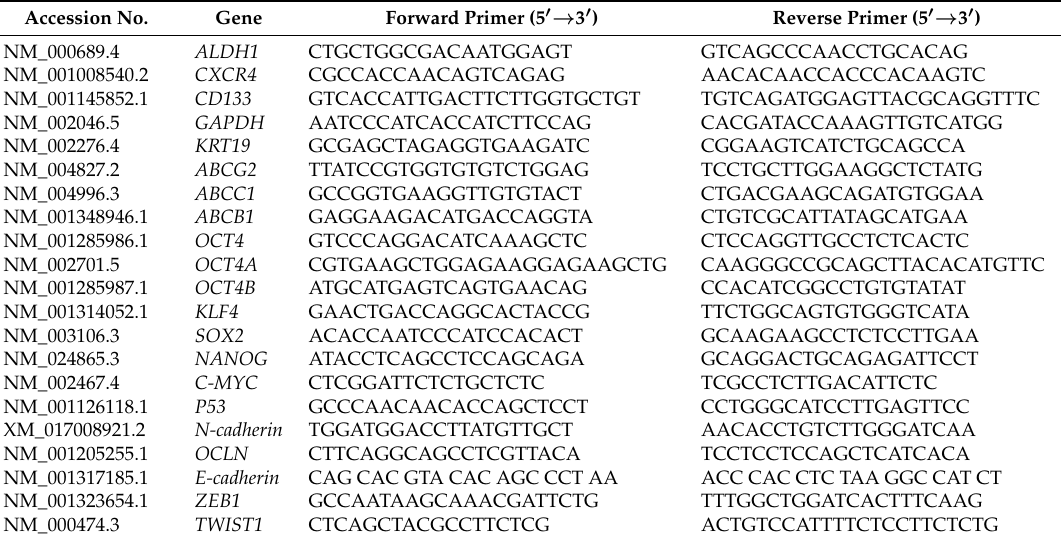
Table 1. Primer sequences for specific genes used for RT-PCR